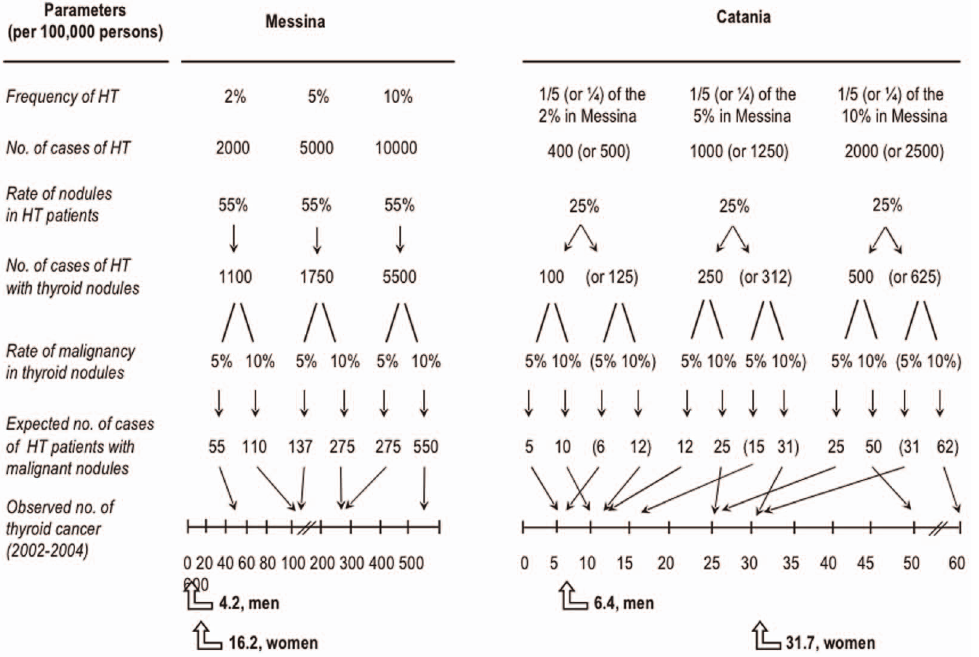
Figure 6. Expected epidemiology of thyroid cancer in patients with the nodular variant of Hashimoto’s thyroiditis (HT) from the provinces of Messina and Catania (based on data reported here for the period 1995–2005) and observed epidemiology (years 2002–2004, as reported in ref. 11). The possible scenarios assume three rates of prevalence of HT in the general population (2, 5 or 10%) and two rates of malignancy for thyroid nodules (5 or 10%). The one-fourth or one-fifth lower magnitude of the HT prevalence in the Catania province is because the 1 to 4.5 ratio observed between Catania and Messina (742 and 3,409 cases, respectively) can be rounded off to either 1.0 to 4.0 or 1.0 to 5.0. The rates of thyroid nodules in HT patients (55% for Messina or 25% for Catania) were taken from the variant ‘‘thyroid nodules regardless of goiter’’ in Table 1 of the present paper. Expected numbers do not change substantially by referring to the period 2002–2004, because cases of HT were 352 in the Catania cohort and 1,351 in the Messina cohort (ratio of 1 to 3.84), with a rate of 26.4% and 56.5% for the variant ‘‘nodules regardless of goiter’’.